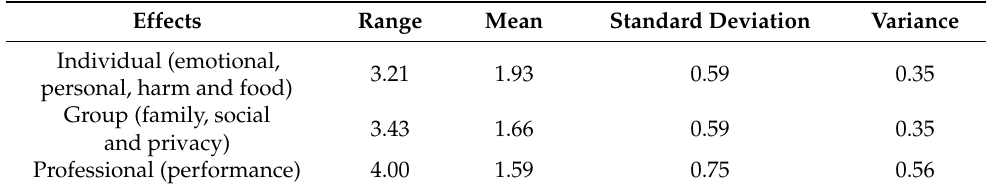
Table 4. Descriptive statistics of negative